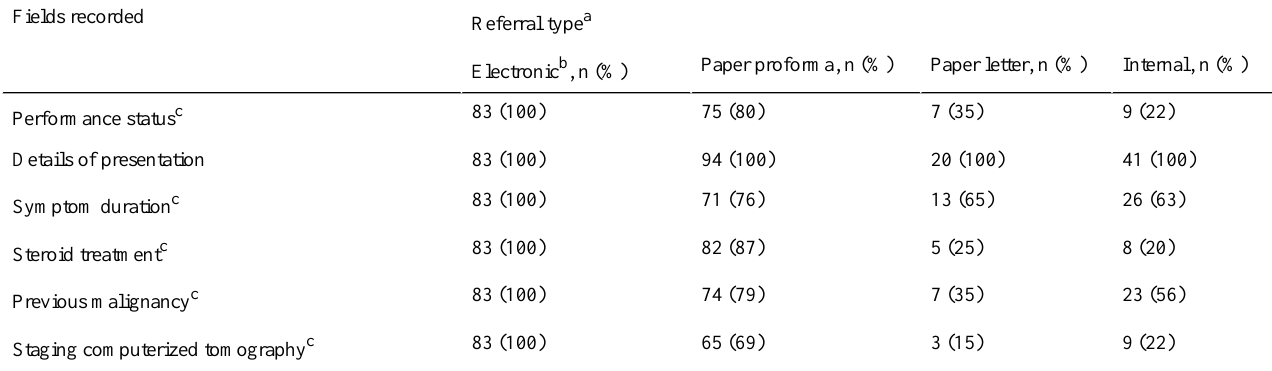
Table 3. Number and percentage of fields recorded, by referral type, excluding unusual and unknown referral pathways.